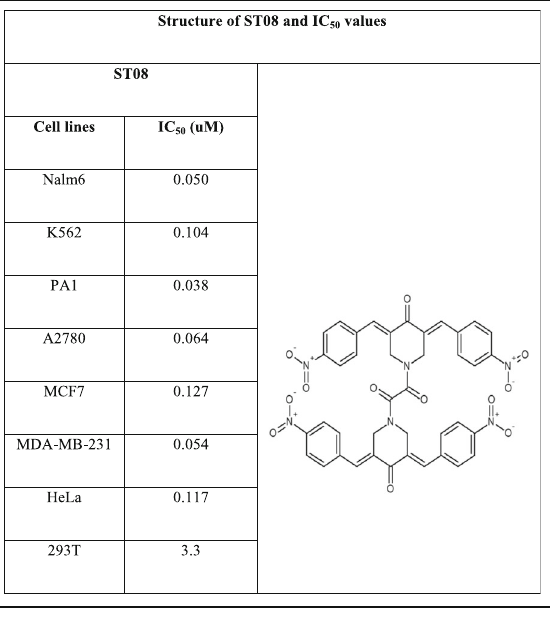
Table 2 Structure of ST08 and IC 50 values. IC 50 values were calculated from the average IC 50 s of all cytotoxicity assays conducted on particular cell line at 48 h, and the results are summarized in micromolar